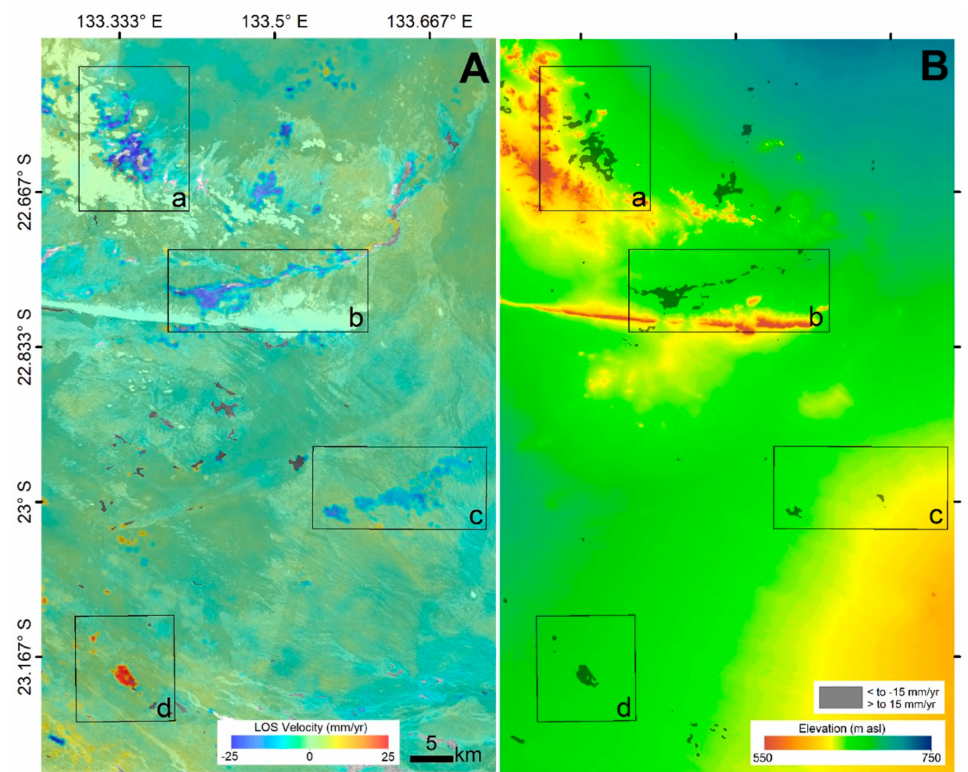
Figure 11. Mapping areas of active geomorphological changes in a desert environment, Northern Territory, using InSAR analysis of Sentinel-1 data between 20170504 and 20190314. ( A ) LoS velocities. Squares highlight the areas with LoS velocities >15 mm/yr in magnitude (a, b, and c are areas of negative LoS velocities; d is an area of positive LoS velocities). ( B ) Digital Elevation Model (ALOS 3D, JAXA, 2019) of the same area. Grey regions are those in A with absolute LoS velocities >15 mm/yr in magnitude and show that these regions are proximal to the large topographic